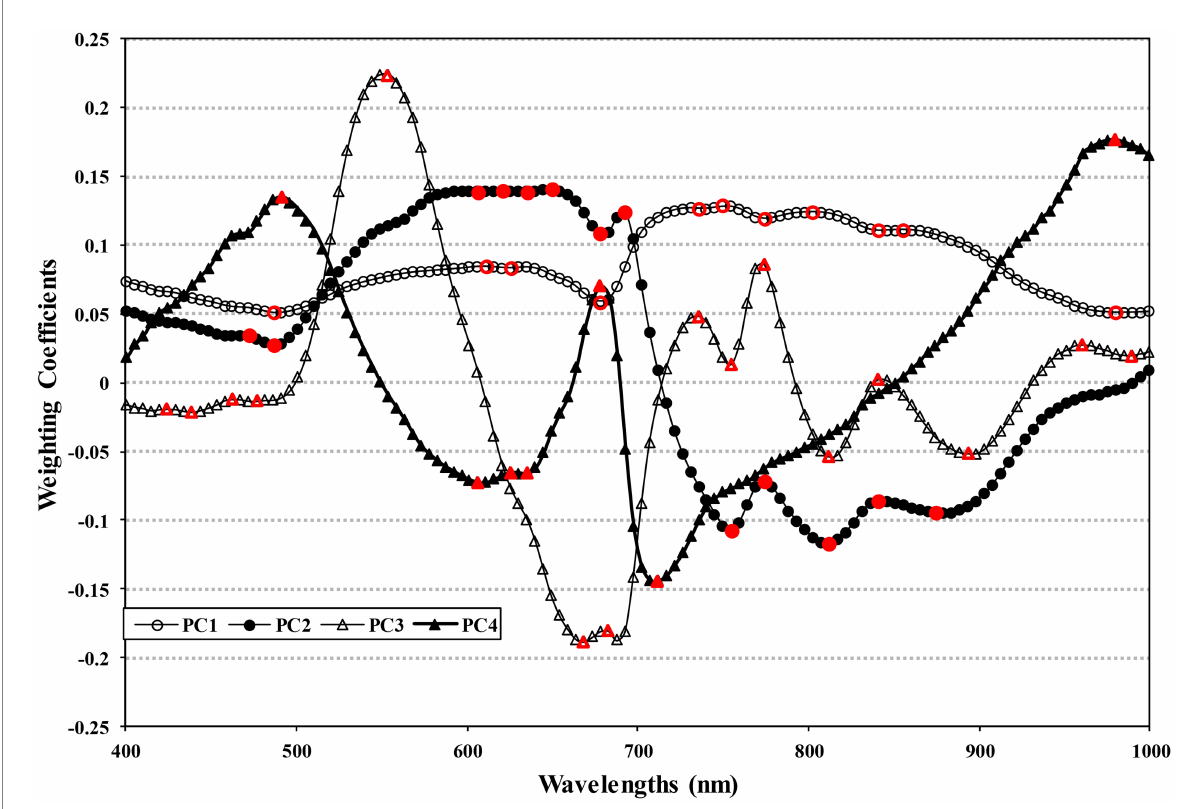
FIGURE 5 Spectral weighting coefficients for the first, second, third, and fourth principal components, with dominant wavebands for pre-selection marked in